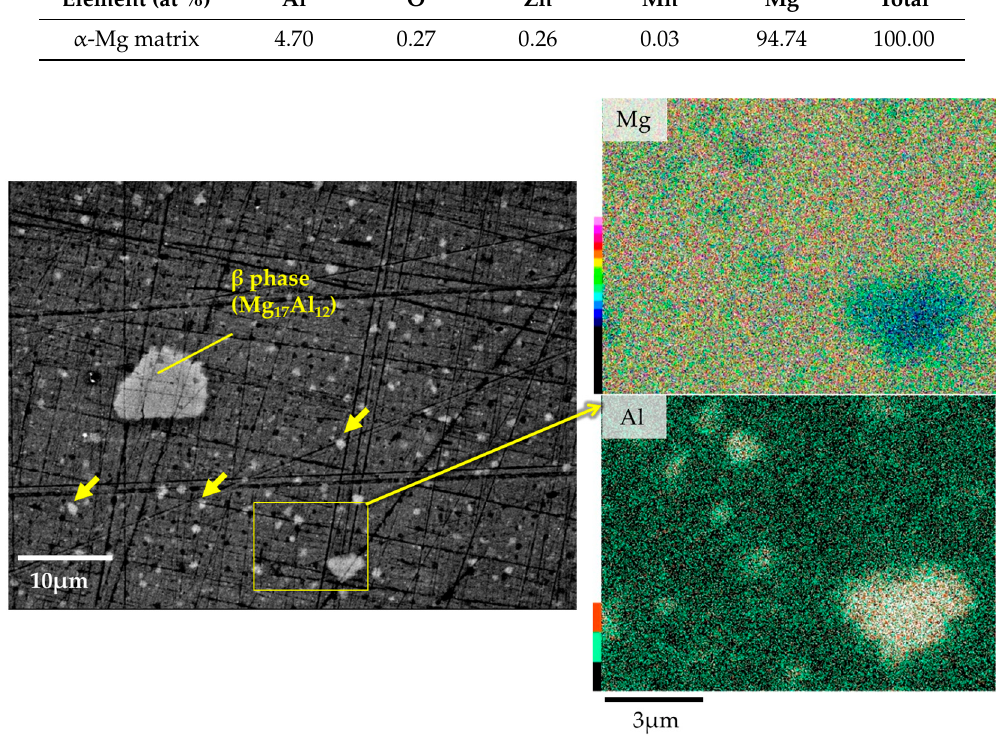
Table 1. Chemical compositions of the α -Mg matrix in AZ61B powder precursor with no CaO particle. Element (at %)